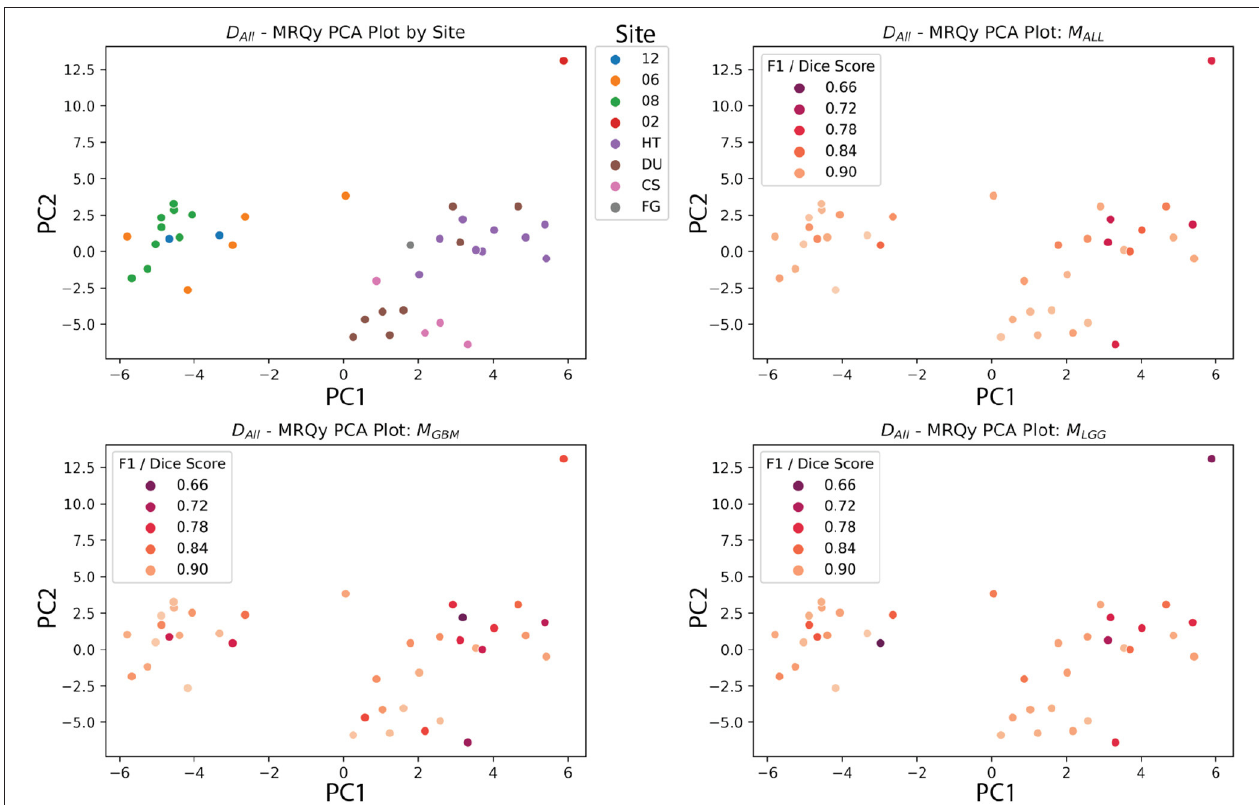
FIGURE 12 | MRQy features after principal component analysis, plotted against site code, and Dice scores of three models. The D ALL test dataset has the first two principal components of the MRQy features plotted. Pairwise t -tests found that three clusters had significant differences in PCA space (06, 08, 12), (HT, DU, CS, and FG), and (02). Notably, these numeric codes happen to correspond to GBM studies, and the letter codes happen to correspond to LGG